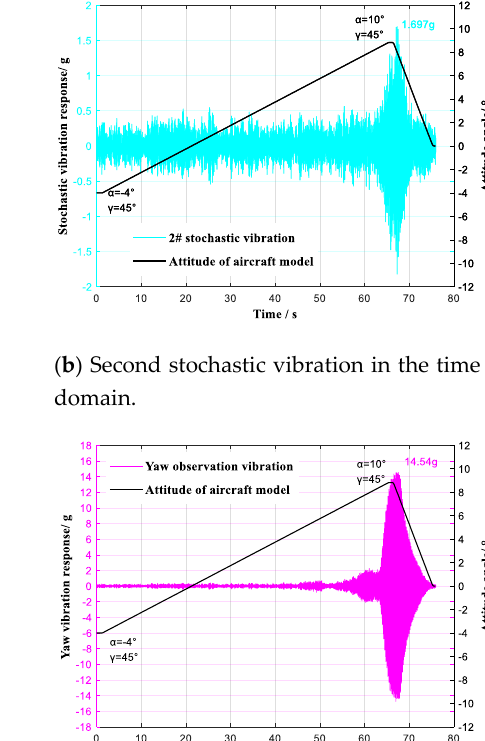
Figure 14. Vibration monitoring with continuous lifting (γ = 0°) of the aircraft model at 0.7 Ma.